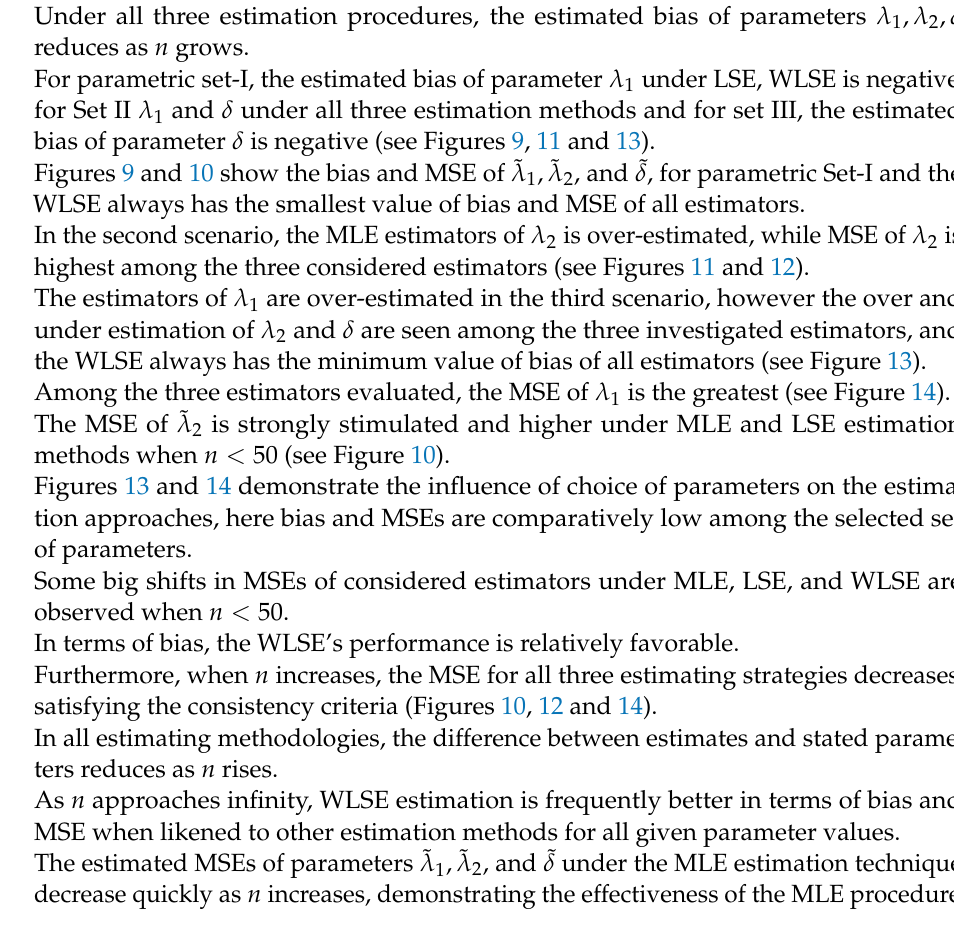
Figure 14. Behavior of MSE of estimators with different methods under parametric set III against n Fig. 14. Behaviour of MSE of estimators with di⁄erent methods under parametric set III against n .